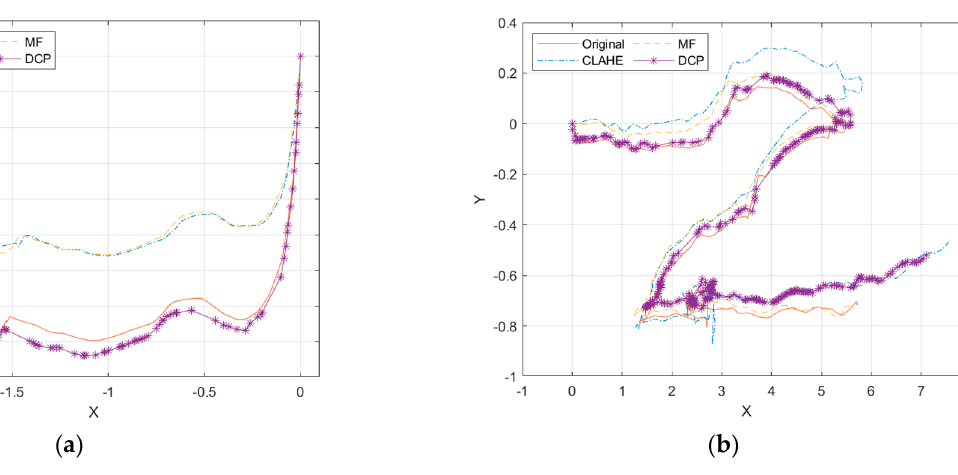
Figure 13. Keyframe motion trajectory. ( a ) Test 1; ( b ) Test 2.